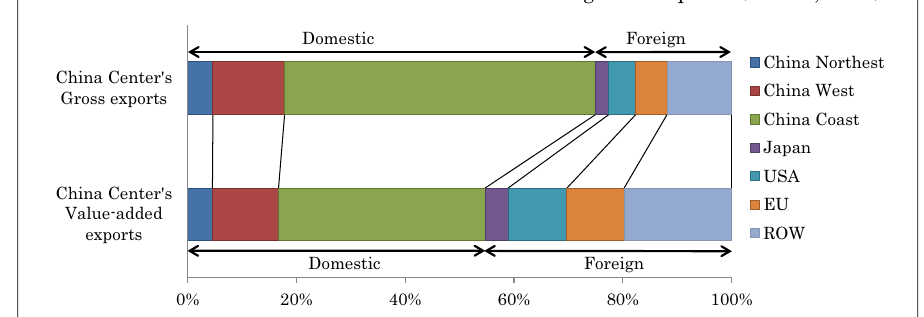
Fig. 3 Gross versus value-added term measure on China’s regional exports (Center